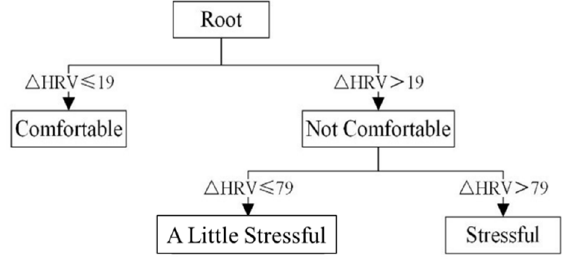
Figure 8. CART algorithm classification diagram.